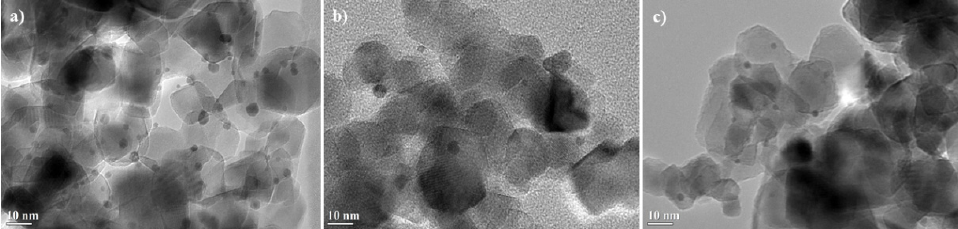
Figure 3. Transmission electron microscopy (TEM) of ( a ) 2%Au/TiO 2 , ( b ) 2%Au 1 Pd 1 /TiO 2 , ( c ) and 2%Au 1 Pt 1 /TiO 2 .